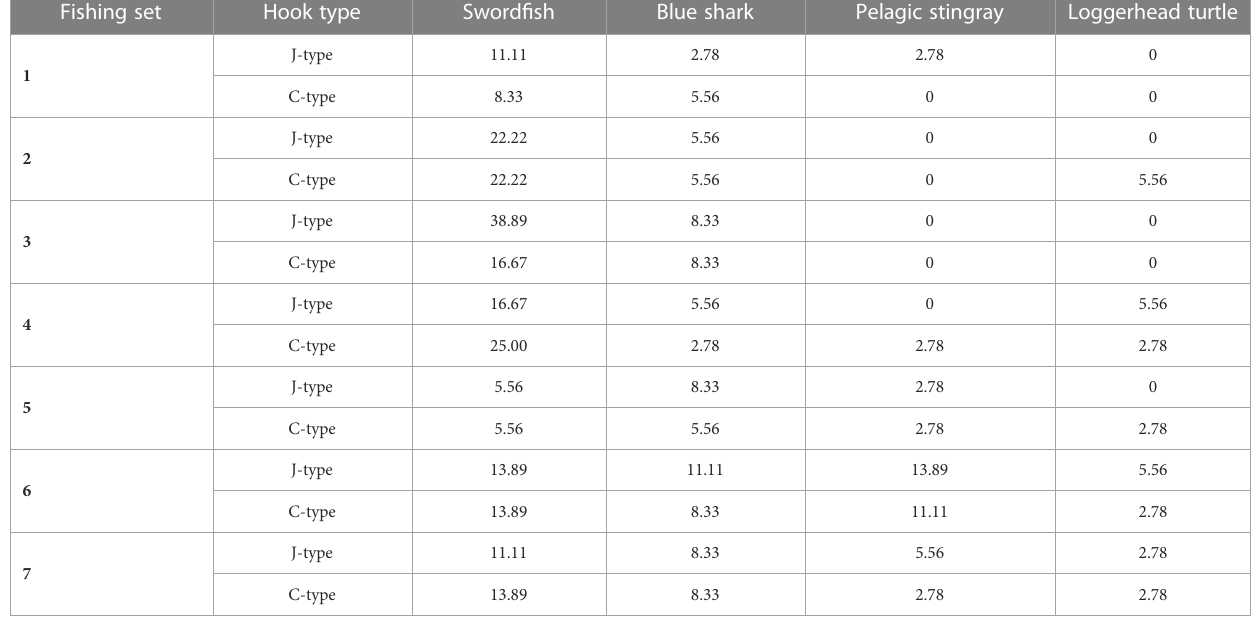
TABLE 3 Estimated mean catch-per-unit-effort (CPUE) for each hook type (C and J) per fi shing set by species (blue shark, loggerhead turtle, pelagic stingray, and sword fi sh). Fishing